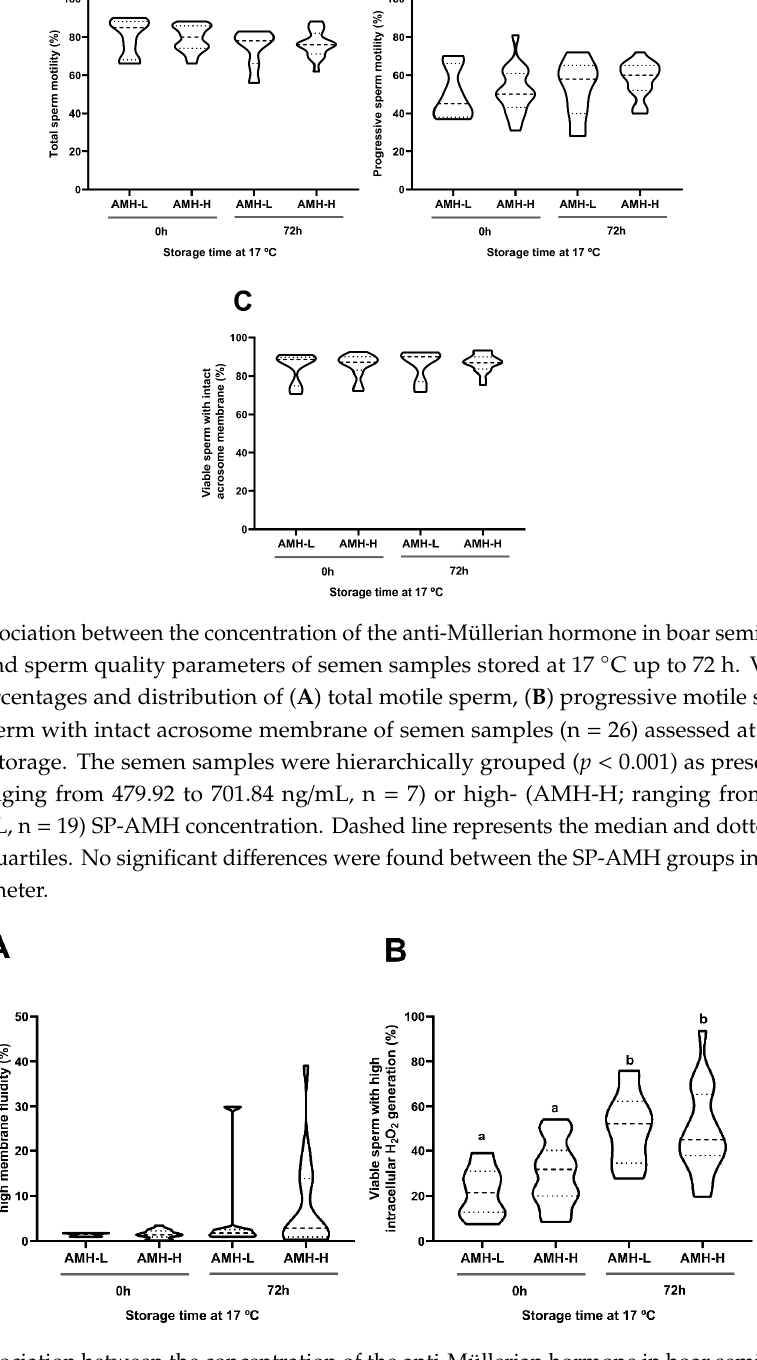
Figure 4. Association between the concentration of the anti-Müllerian hormone in boar seminal plasma (SP-AMH) and sperm functionality parameters of semen samples stored at 17 ◦ C up to 72 h. Violin plots represent percentages and distribution of viable sperm with high ( A ) membrane fluidity and ( B ) intracellular H 2 O 2 levels of semen samples (n = 26) assessed at 0 and 72 h of liquid-storage. The semen samples were hierarchically grouped ( p < 0.001) as low- (AMH-L; ranging from 479.92 to 701.84 ng / mL, n = 7) or high- (AMH-H; ranging from 770.53 to 1096.72 ng / mL, n = 19) SP-AMH concentration. Dashed line represents the median and dotted lines the 25 and 75% quartiles. Di ff erent superscript letters ( a-b ) indicate significant di ff erences between evaluation times within each SP-AMH group ( p <